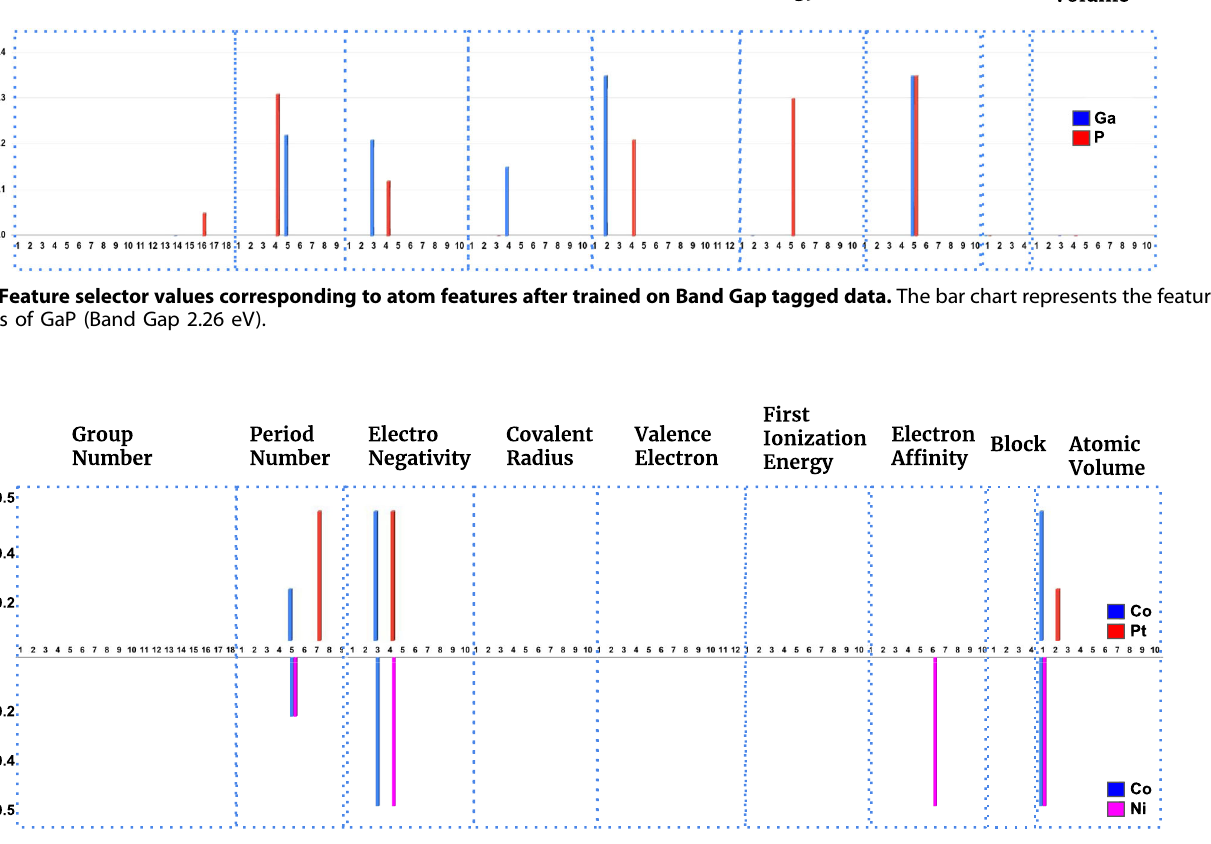
Fig. 6 Feature selector values corresponding to atom features after trained on Magnetic Moment tagged data. The top bar chart represents the feature weights of CoPt and the bottom chart represents the feature weights of